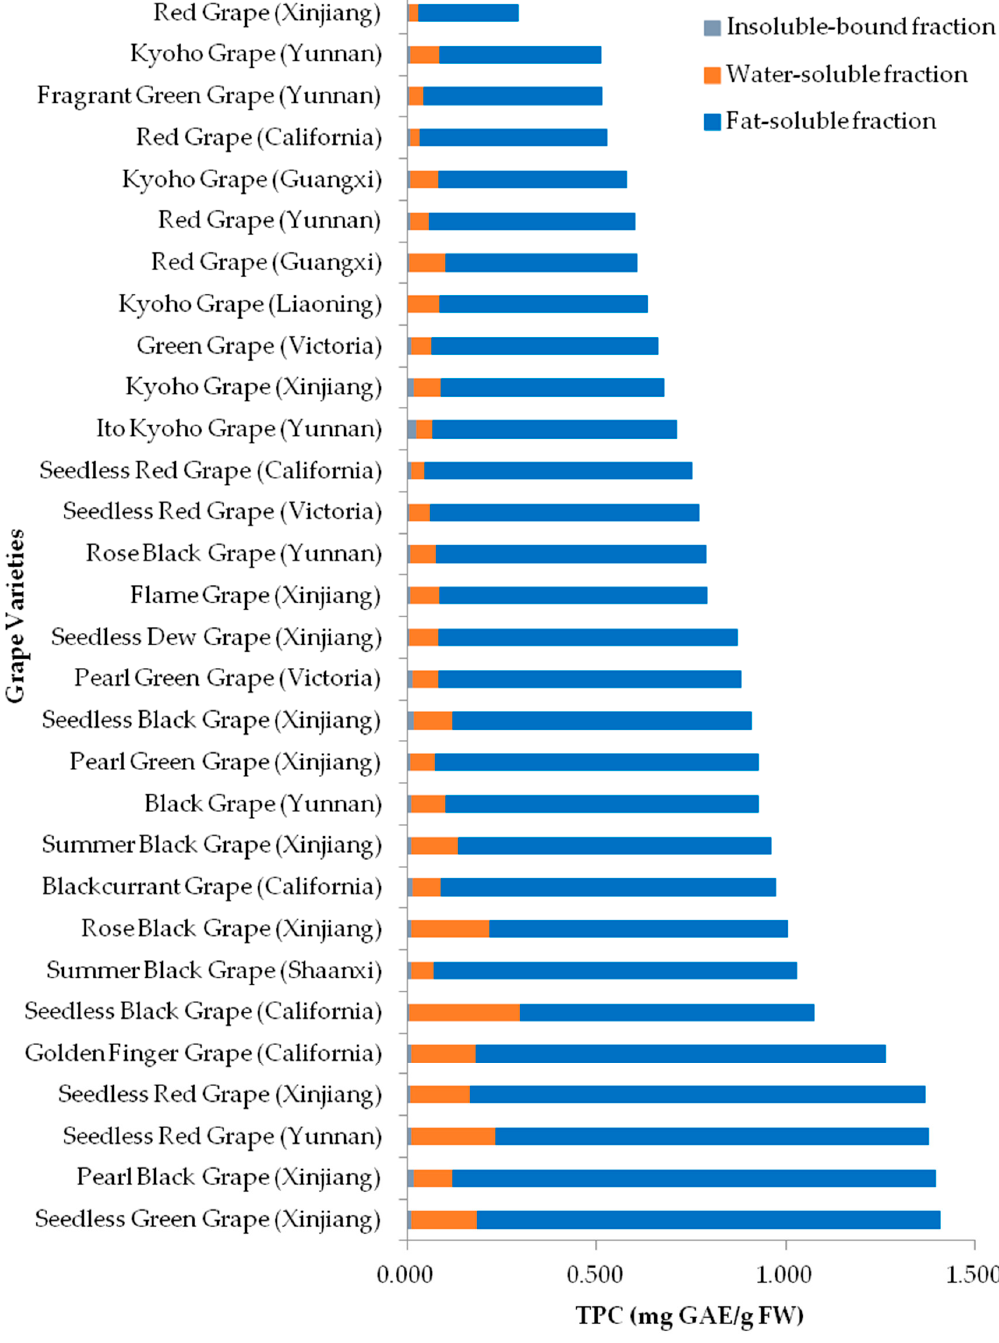
Figure 4. Total phenolic contents (TPC) of 30 grape pulps.